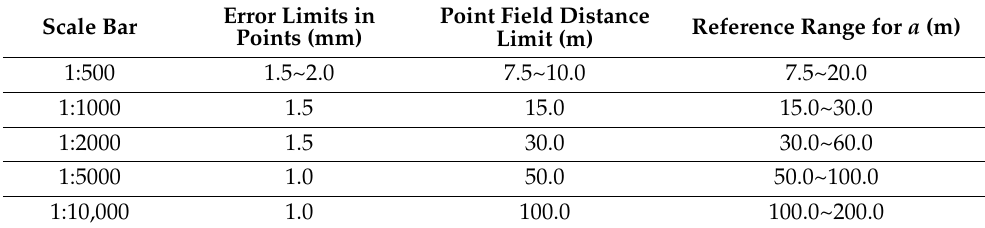
Table 2. Reference range of circle radius a .